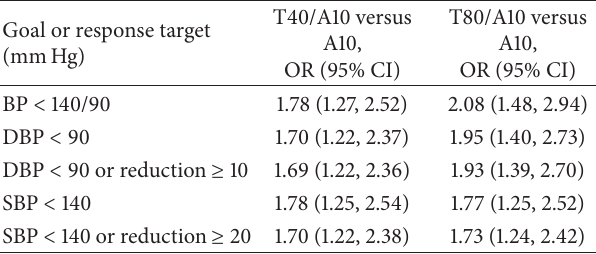
Table 4: OR for goal attainment and response rates in patients not at goal with A10